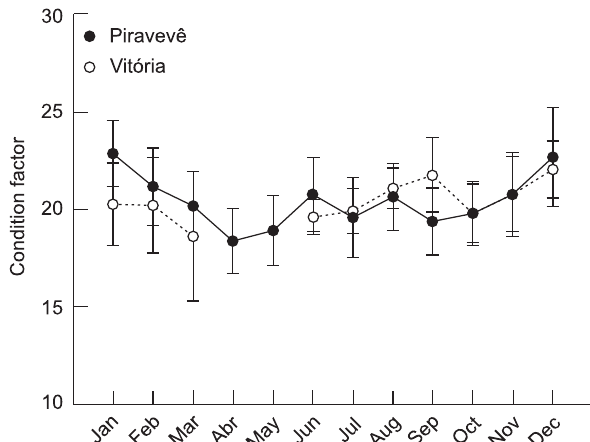
Figure 7. Mean Condition Factor by month for H. marginatus sampled in two sub-basins (Piravevê and Vitória) of the Ivinhema River. Vertical bar represents standard deviation of average values.